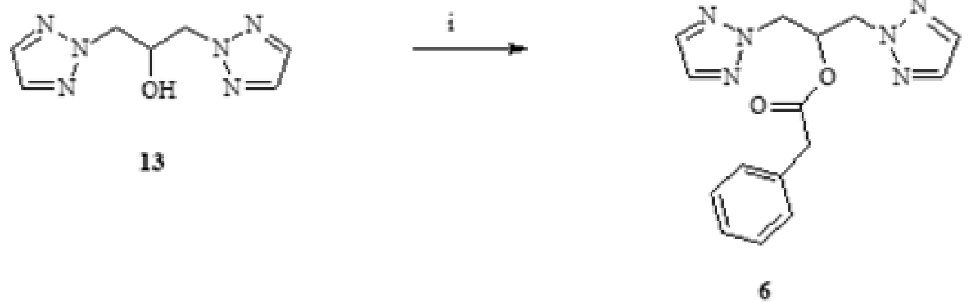
Figure 9. Scheme of synthesis of 1-[2-(2H-tetrazol-2-ylmethyl) prop-2-en-1-yl]-1H-tetrazole( 11 ). i— sodium, methanol, ii—acetonitrile, reflux. Figure 10. Scheme of synthesis of 1,3-di(tetrazol-2-yl)-2-chloromethylpropane ( 12 ). i—sodium, methanol, 1,2,3-triazole, reflux. [2-(2H-tetrazol-2-ylmethyl)prop-2-en-1-yl]-1H-tetrazole ( 11 ) was prepared by heat- ing tetrazole sodium salt with a solution of 3-chloro-2-(chloromethyl)prop-1-ene in ace- tonitrile for 4 days. 1,3-di(tetrazol-2-yl)-2-chloromethylpropane ( 12 ), also obtained from tetrazole sodium salt and 2-[3-chloro-2-(chloromethyl)propyl]-2H-tetrazole in acetoni- trile, was stirred and heated to gentle reflux for 10 days. The structures of all compounds ( 2–15 ) were determined based on 1 HNMR and 13 CNMR GC-MS spectroscopic analysis.